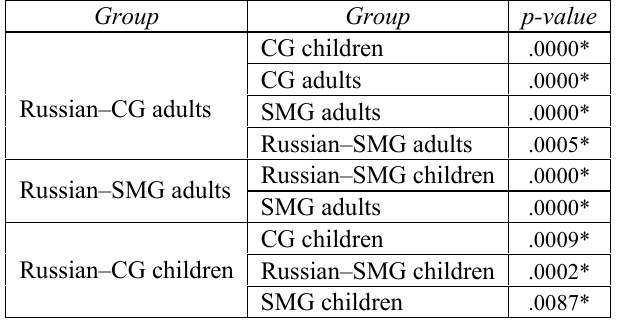
Table 7: t-test between means analysis